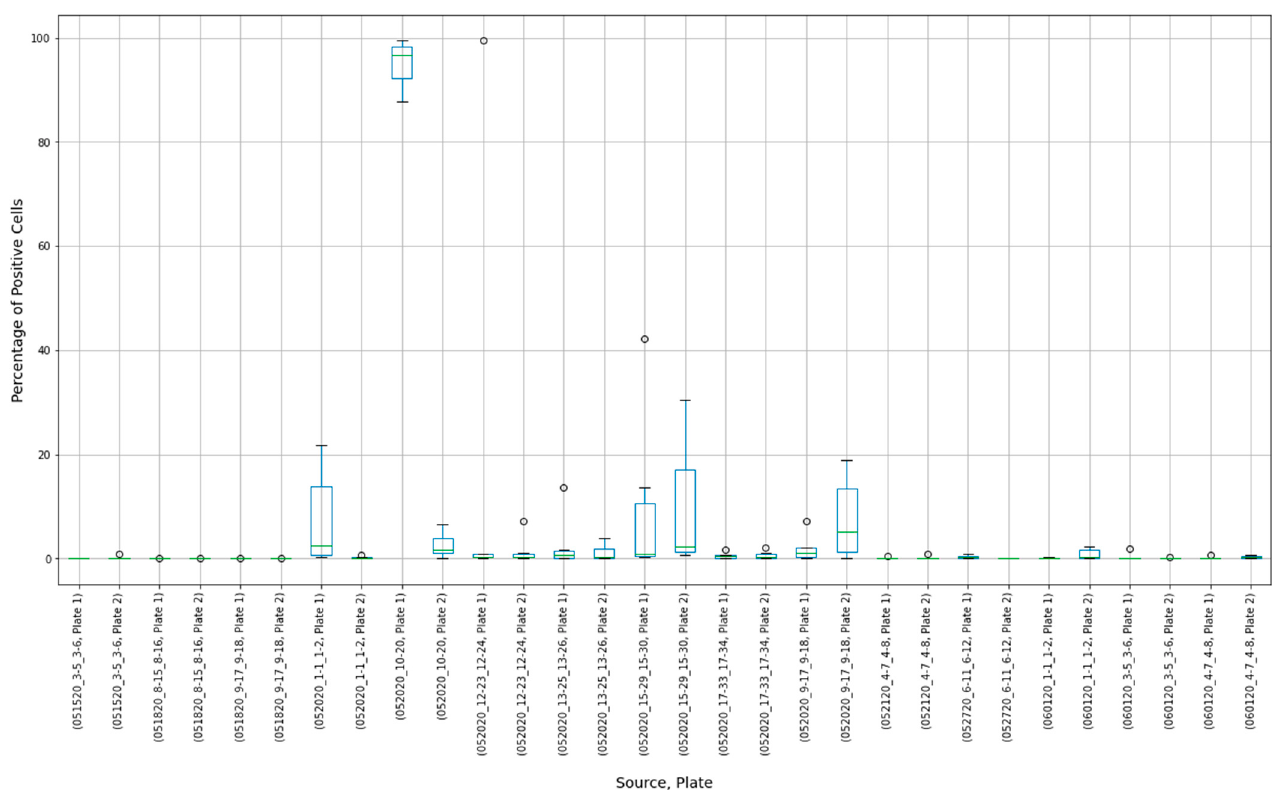
Figure 4. Box plot results of cell control observations showing variability between controls in individual experimental runs.